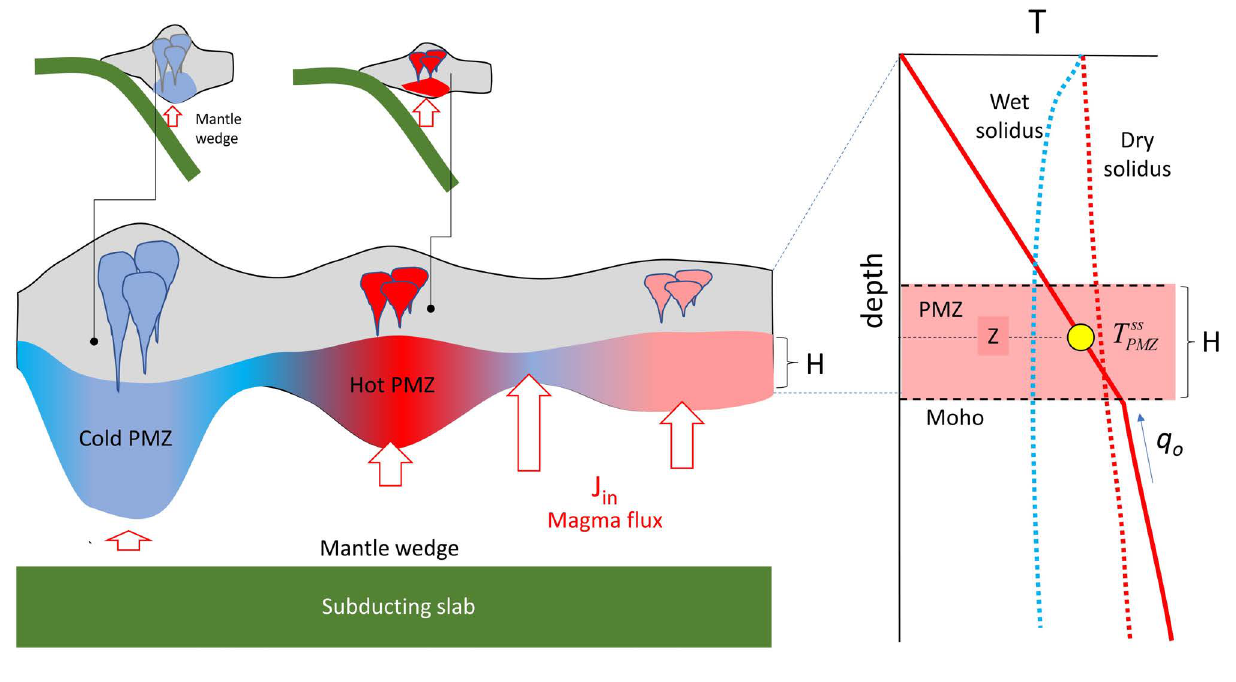
Figure 3: Conceptual cartoon of a lower crustal Partially Molten Zone (PMZ) in volcanic arcs. Base of the PMZ corresponds to the base of the arc crust. Top of the PMZ corresponds to the transition from a partially molten lower crust to a cold, melt-free crust. This transition is controlled by the intersection of the geotherm (red line in graph) with the water-saturated solidus (blue line). Beneath the arc crust lies the convecting asthenospheric mantle wedge (and a thin lithospheric mantle). This mantle wedge is underlain by the subducting slab (oceanic lithosphere), which ultimately drives upwelling within the mantle wedge. Such upwelling drives decompression melting of the mantle, leading to a magmatic flux J into the PMZ. As crustal thickness increases (Z), J decreases. in in The PMZ is characterized by a thickness H and a steady state temperature T SS . Temperature of the PMZ is PMZ controlled by conductive heat loss through the solid upper crust and heat gain from below via magmatic recharge J in and a basal conductive heat flow q o from the